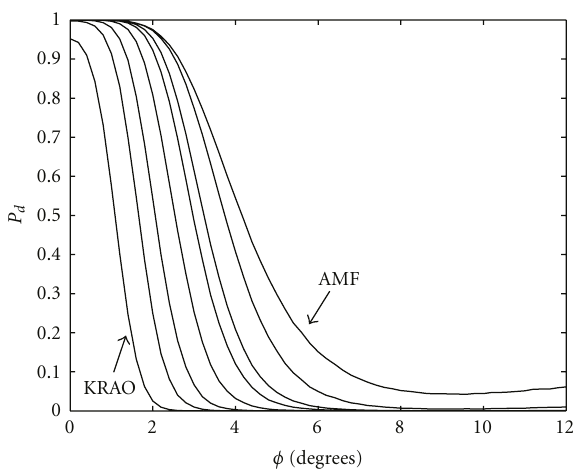
Figure 11: P d versus φ for the KRAO-ASB with N = 8, K = 24, ρ = 1 . 2, and SNR = 18